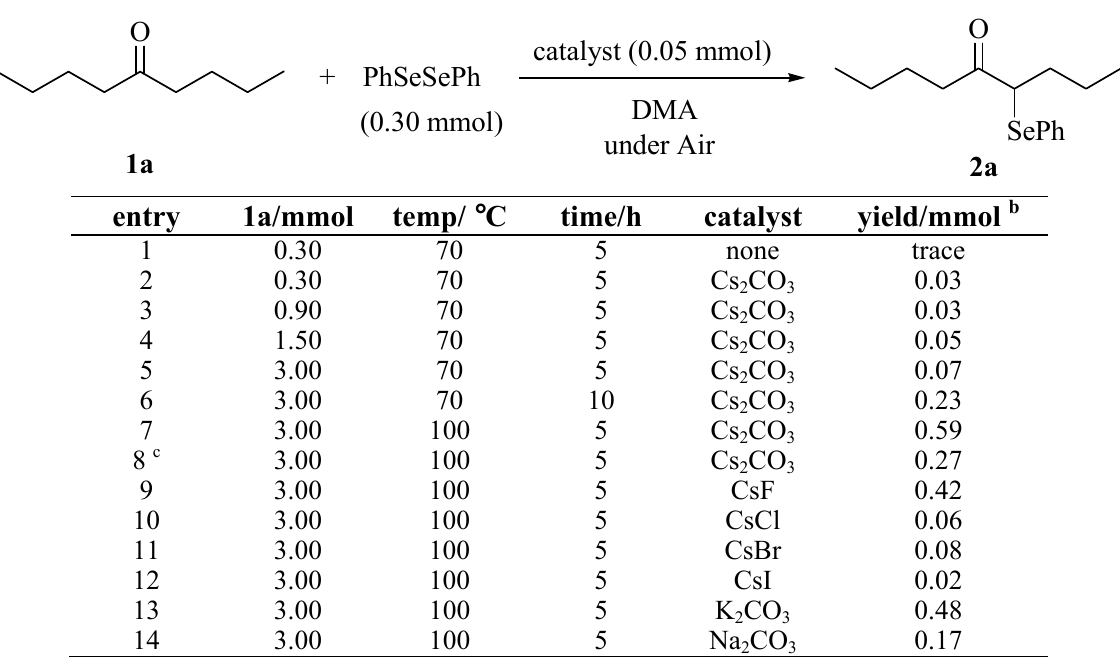
Table 1. Reaction of 5-nonanone with diphenyl diselenide. a